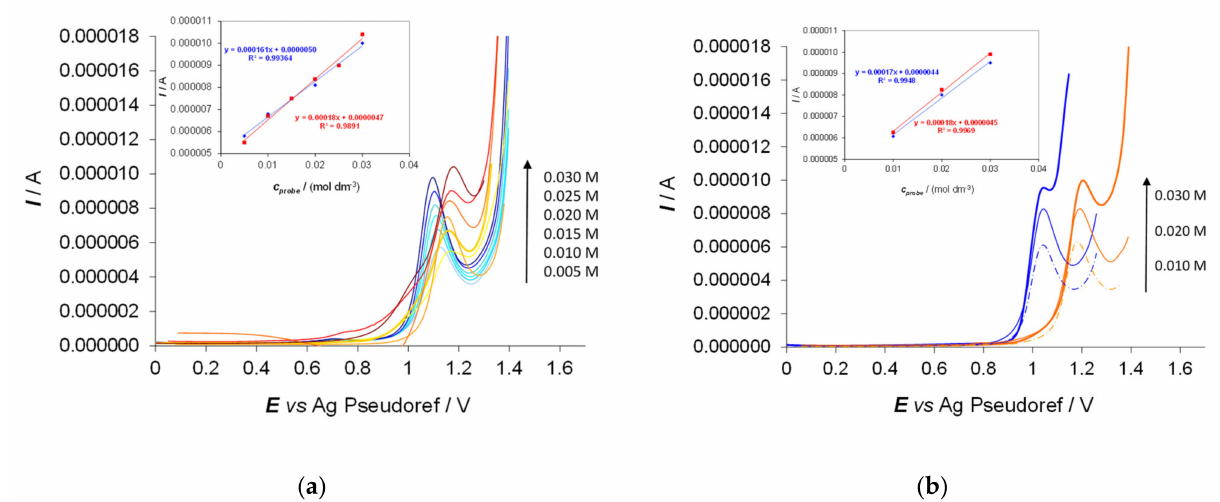
Figure 12. Verification of peak current vs concentration linearity for each enantiomer. ( a ) L - and D -Trp (blue and orange lines of increasing darkness, respectively) in the 0.005–0.03 M concentration range with 2 (0.03M) in (BMIM)NTf 2 . ( b ) L - and D -Trp (blue and orange, respectively) in the 0.01–0.03 M concentration range with 3 (0.03M) in (BMIM)NTf 2 .